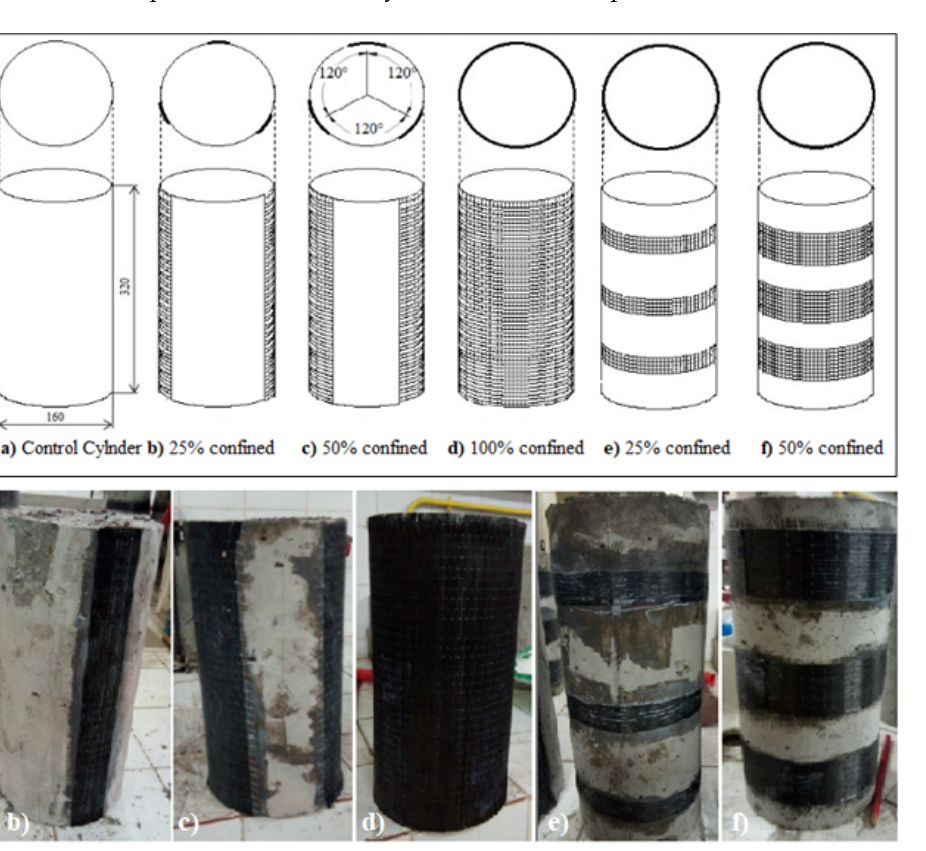
Table 5. Percentages of CFRP wraps used as compared to the cylinder’s surface total.